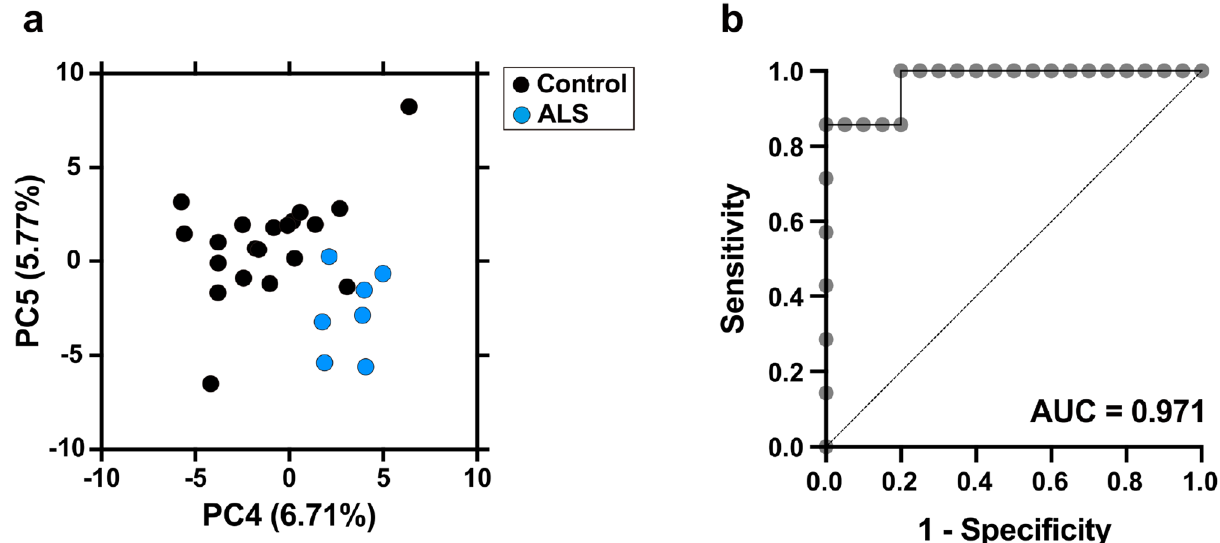
Figure 1. ( a ) Principal component analysis (PCA) of plasma metabolites in controls (n = 20) and amyotrophic lateral sclerosis (ALS) patients (first ALS group, n = 7). Two-dimensional plot of PCA scores of PC4 and PC5 in control subjects (black) versus ALS patients (blue) as analyzed according to the normalized values of plasma metabolites detected in participants in the pilot study. ( b ) Receiver operating characteristic (ROC) curve analysis using the values of the top four statistically significant metabolites (3-methoxytyrosine, dyphylline, N6-acetyllysine, and ribose-5-phosphate) from controls and ALS patients. PC principal component, AUC area under the curve.